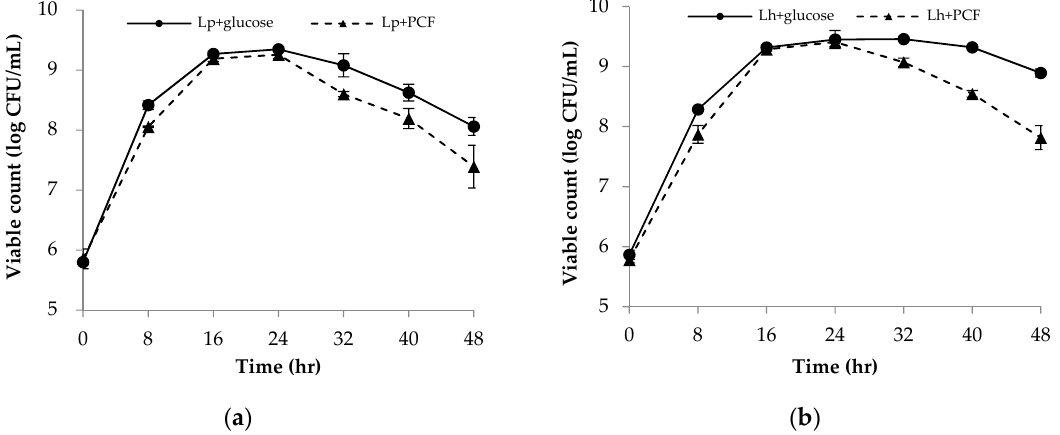
Figure 1. Changes in cell viability counts of Lp ( a ) and Lh ( b ) with glucose or CFE. Values are expressed as mean ± SD.